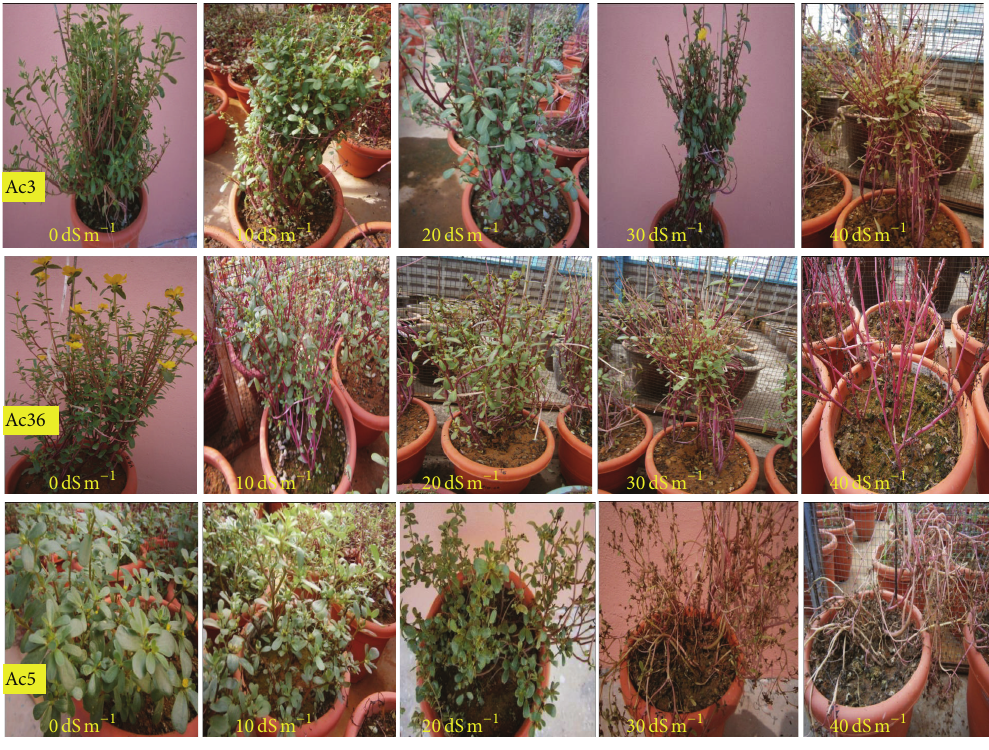
Figure 1: Effect of salinity on different purslane